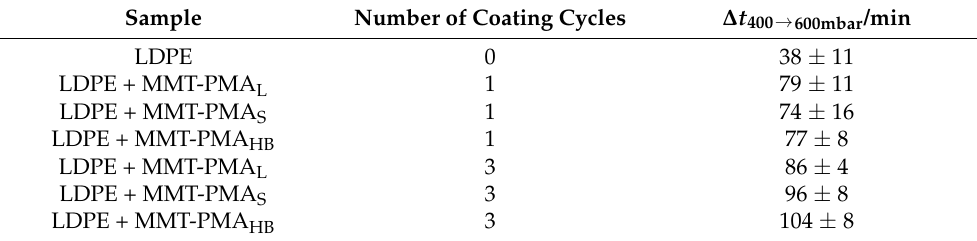
Figure 2. Pressure-time-profiles of LDPE foils coated with MMT-PMA L , MMT-PMA S , or MMT- PMA HB . Numbers in brackets indicate the number of coating cycles. For visual clarity, only three error bars per curve are shown. Errors are determined as the standard deviation from at least three measurements. Table 1. Average durations Δ t 400 → 600mbar —the time difference between 400 and 600 mbar in the sample chamber—for LDPE-foils coated with MMT nanosheets modified with PMA L , PMA S or PMA HB . Errors are obtained as the standard deviation of at least three measurements.